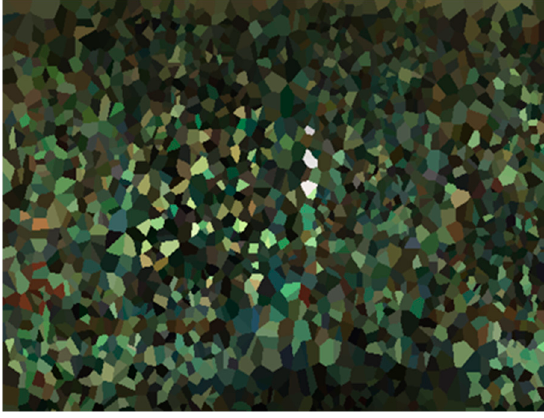
Figure 16. Low-resolution texture creation.